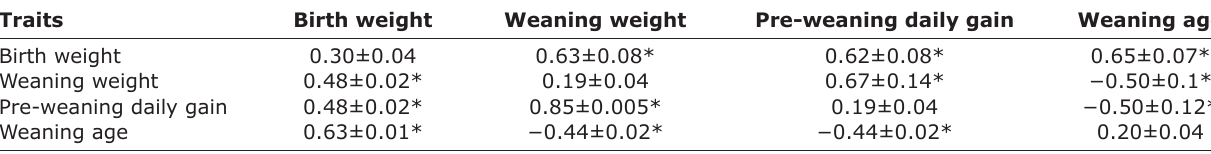
Table-4: Heritability (values in diagonal direction), genetic (values above diagonal), and phenotypic (values below diagonal) correlations between pre-weaning growth traits in Awassi lambs.